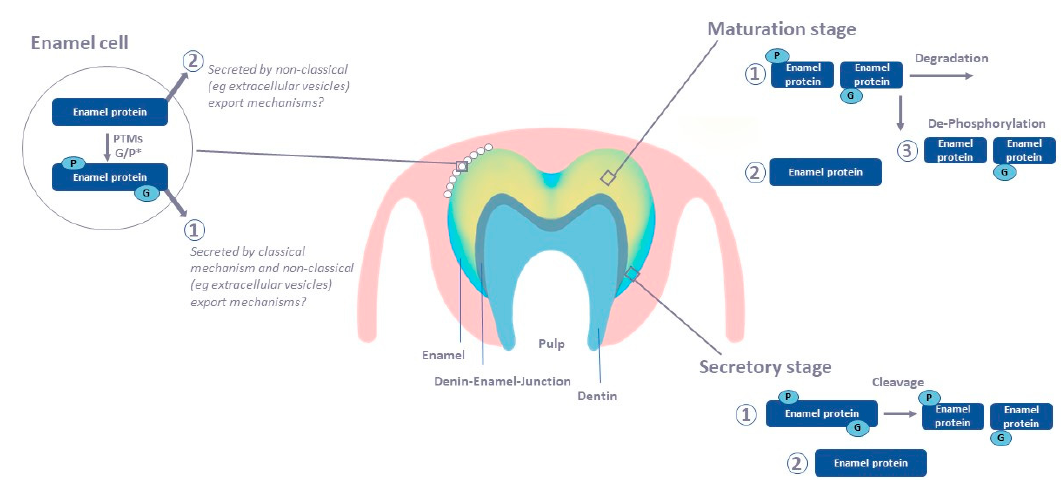
Figure 5. Schematic of potential mechanism of post-translational modifications and secretion of enamel proteins during the course of enamel formation. (1) Post-translational modifications of enamel proteins occur with the ameloblast. These modifications are used as a signal to be secreted, cleavage during the secretory stage and degraded during the maturation stage. (2) Some of the enamel proteins generated with the ameloblast lack post-translational modification and they are secreted via non-classical pathways. These proteins would be less or not degraded during the mineralization process. (3) Alternative to pathway 1, de-phosphorylation to account for the presence of non-phosphorylated enamel proteins in mature enamel. (P) phosphorylation, (G) glycosylation; Blue: enamel that is more recently deposited, younger, with higher protein content. Yellow: enamel that is further developed and more mature, older enamel, more mineralized with lower protein